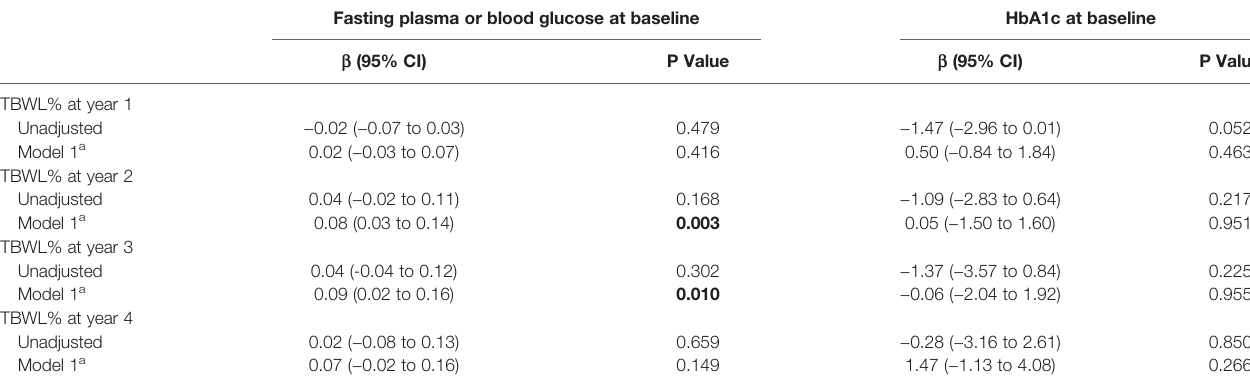
TABLE 3 | Associations between TBWL% and fasting plasma glucose and glycated hemoglobin (HbA1c) at baseline. Fasting plasma or blood glucose at baseline HbA1c at